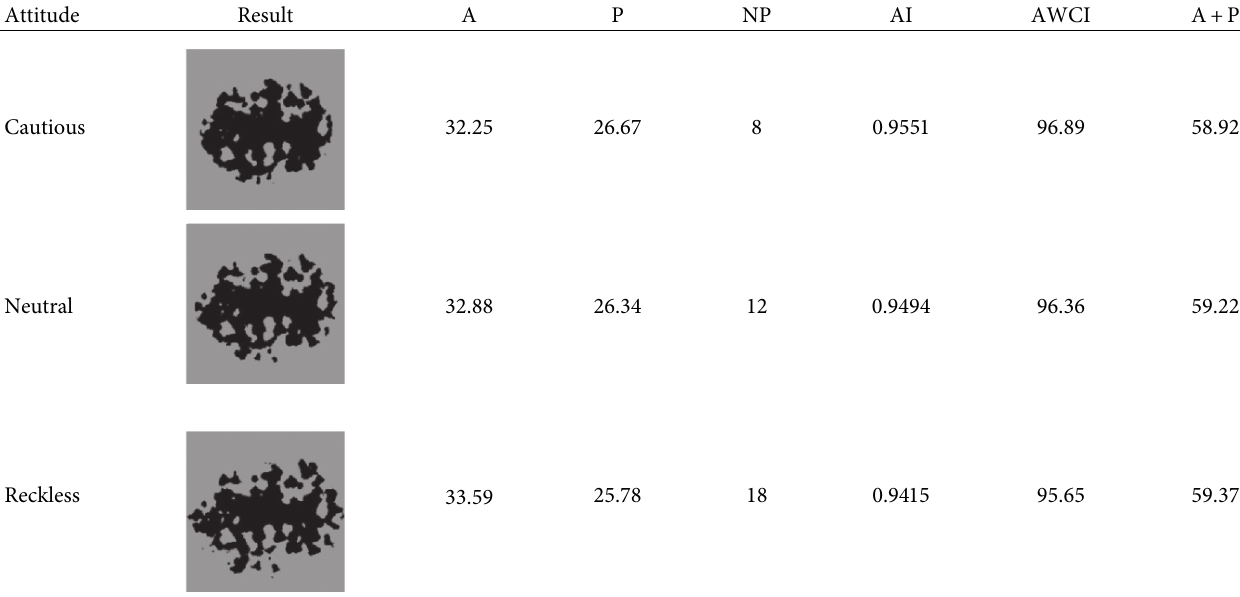
Table 1: Results of land development.